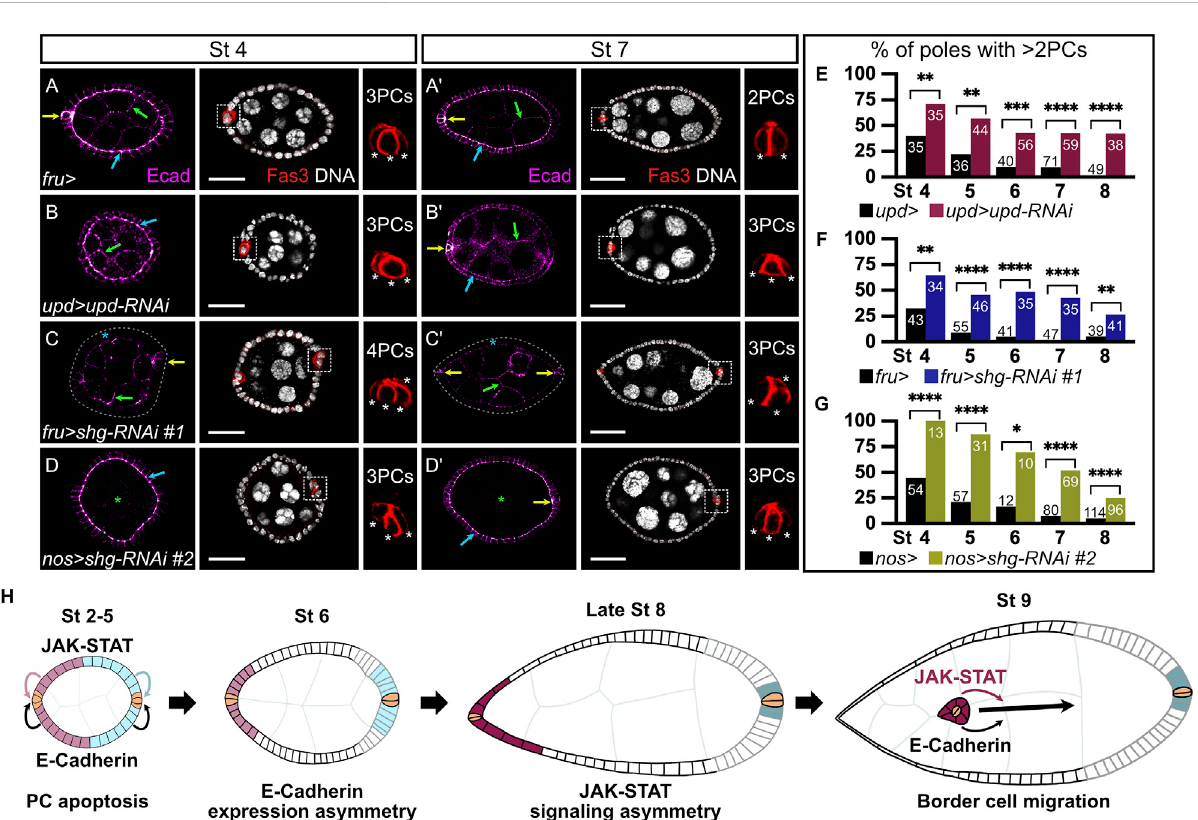
FIGURE 2 SomaticandgerminalE-cadherinisnecessaryforJAK-STAT-mediatedpolarcellapoptosis.Inallimagesanddrawings,theanterioristotheleft, except for polar cell (PC) magni fi cations for which apical side is up. Follicles at stages 4 (A – D) and 7 (A 9 – D 9 ) of oogenesis are shown. E-cadherin (Ecad, “ magenta hot ” fi lter, from magenta, low intensity, to white, high intensity) and the PC marker Fasciclin3 (Fas3, red) are detected by immunostainings andDNA byDAPI (grey). E-cadherindetection isindicated infollicle cells (FCs) bybluearrows,in p Cs byyellowarrows,and in germline cells by green arrows. To assess the ef fi ciency of PC apoptosis after stage 5 of oogenesis, we used Fas3 staining to count PC numbers at various stages. In the images with Fas3 and DAPI stainings, each white dotted box highlights one PC group, which is magni fi ed to the right to depict how p Csare counted (each white asterisk indicates one PC). PCsattheopposite folliclepoleare not always visibleon thedisplayedzsections. (A,A 9 ) Follicles from females carrying the fru-Gal4 driver, as a control for PC apoptosis. Although supernumerary p Cs can still be detected at stage 4 (A) , only 2 are normally found at stage 7 (A 9 ) . E-cadherin is detected in PCs, in germline cells and apico-laterally in FCs. (B,B 9 ) Follicles from females expressing RNAi targeting upd in p Cs driven by upd-Gal4 . These follicles present a defect in PC apoptosis, as illustrated by the presence of supernumerary p Cs at stage 7 (B 9 ) . (C,C 9 ) Follicles from females expressing the RNAi line #1 targeting shg driven by fru-Gal4 to knock-down shg in FCs,except p Cswhere fru-Gal4 isnotexpressed.E-cadherinisnotdetectedinFCs(blueasterisk),butisstilldetectedinthegermlineandinPCs.Gray dotted line delimits the basal side of the follicular epithelium. The presence of supernumerary p Cs at stage 7 (C 9 ) indicates a defect in the PC apoptosis process. (D,D 9 ) Follicles from females expressing the RNAi line #2 targeting shg with the germline speci fi c nos-Gal4 driver, showing that E-cadherinisnotdetectedingermcells(greenasterisk),butismaintainedinthefollicularepitheliumandPCs.Thepresenceofsupernumerary p Csat stage 7 (D 9 ) indicates a defect in the PC apoptosis process. (E – G) Apoptosis defect quanti fi cation illustrated by the percentage of poles with more than 2 PCs at various stages of oogenesis when upd is knocked down in PCs (E, pink bars), and when shg is knocked down in FCs (F, blue bars) or in germ cells (G, green bars) compared to control conditions (females carrying only the corresponding Gal4 drivers, black bars). Numbers in bars correspond to thenumberofcounted poles.As intheJAK-STAT knock-downcondition, asigni fi cantperturbation inPC apoptosis isobserved upon somatic and germinal shg knock-down at all stages of oogenesis analyzed. (H) Schematic drawing representing the E-cadherin expression pattern (black and gray lines for high and low E-cadherin, respectively), together with JAK-STAT signaling dynamics (pink and blue- fi lled FCs, same color code as presented in Figure 1) in the follicular epithelium and recapitulating JAK-STAT and E-cadherin shared roles at different stages of oogenesis: for PC apoptosis between stages 2 and 5 and for border cell migration at stage 9. p Cs are indicated in beige. St: stage. Statistical tests: Chi2. Stars indicate statistically signi fi cant differences. * p < 0.05, ** p < 0.01, *** p < 0.001, and **** p < 0.0001. Scale: (St 4) 20 µm, (St 7) 30